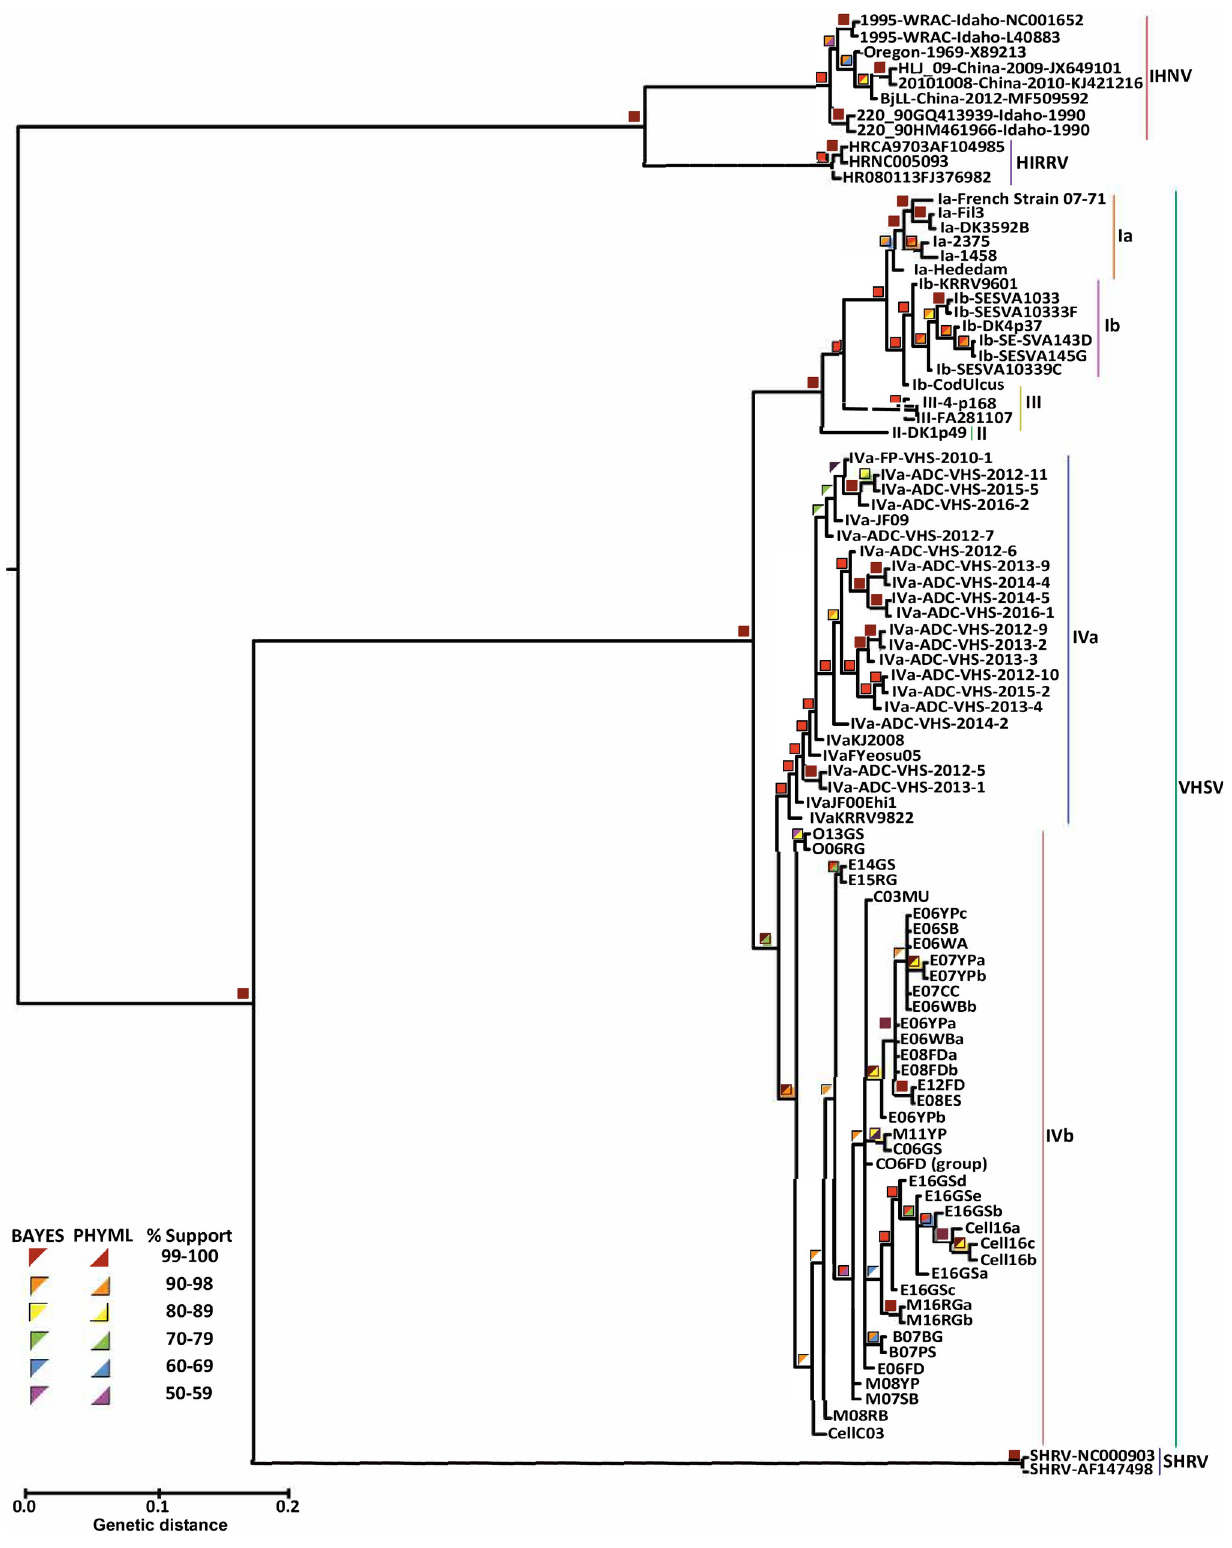
Fig 3. Novirhabdovirus phylogenetic tree, based on aligned whole genome sequences analyzed here (see S1 and S2 Tables) using maximum likelihood and Bayesian analyses. Colored squares designate support values, top left half = Bayesian posterior probabilities, bottom right = 500 bootstrap pseudoreplicates. Tree is rooted to the Snakehead novirhabdovirus (SHRV, GenBank: AF147498).